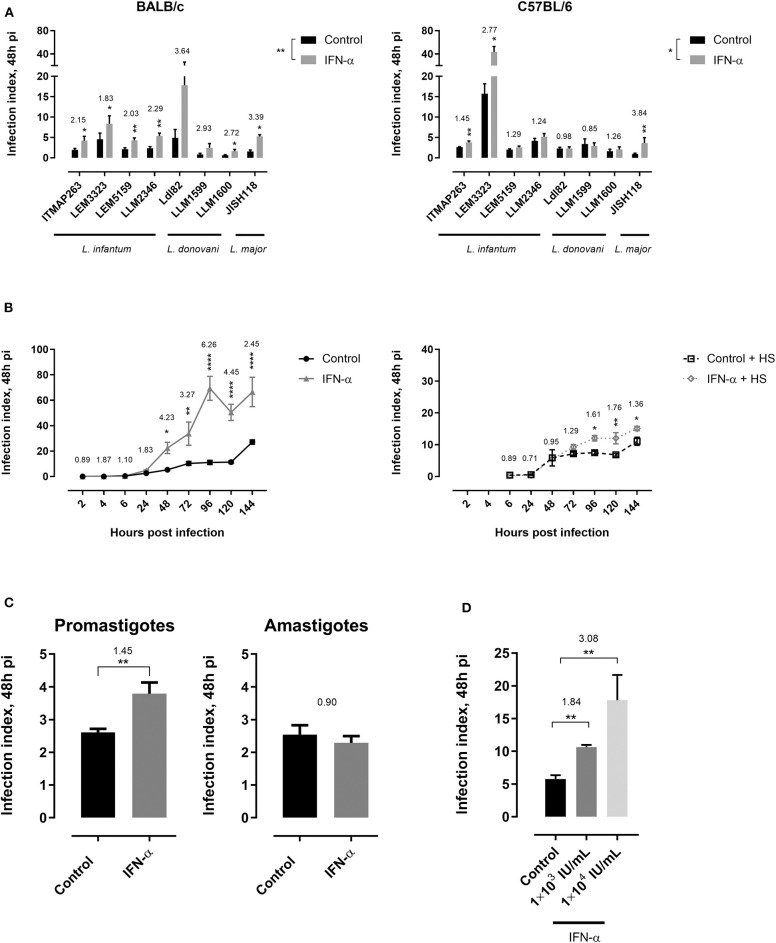
Type I interferon induces a higher susceptibility of macrophages to infection with visceral Leishmania species. (A) Effect of IFN-α stimulation on the infection index of different Leishmania species/strains 48 h post-infection in bone marrow-derived macrophages from BALB/c (left) and C57BL/6 (right) mice. Cells were either left unstimulated (control) or were stimulated with IFN-α 2 days prior to infection with metacyclic promastigotes (5:1 infection ratio). Results in this panel are based on two experiments run in triplicate. (B) Effect of IFN-α stimulation on the infection index of L. infantum LEM3323 at different time points post-infection in bone marrow-derived macrophages from C57BL/6 mice. Cells were either left unstimulated (control) or were stimulated with IFN-α 2 days prior to infection with metacyclic promastigotes (5:1 infection ratio). Extracellular promastigotes were either washed (right panel) or not (left panel) with PBS 24 h after infection and cells were thereafter incubated with medium containing 2% horse serum (HS). Results in this panel are based on two experiments run in triplicate. (C) Infection index in bone marrow-derived cells of C57BL/6 mice either or not stimulated with IFN-α following infection with L. infantum ITMAP263 metacyclic promastigote or hamster spleen-derived amastigotes. Results in this panel are based on two experiments run in quadruplicate. (D) Effect of different doses of IFN-α stimulation on the infection index of LEM3323 48 h post-infection in bone-marrow derived macrophages from C57BL/6 mice. Results in this panel are based on two experiments run in triplicate. All results are expressed as mean ± standard error of mean (SEM) and the ratio of IFN-α/control is stated above the bars (*p < 0.05; **p < 0.01; ****p < 0.0001).